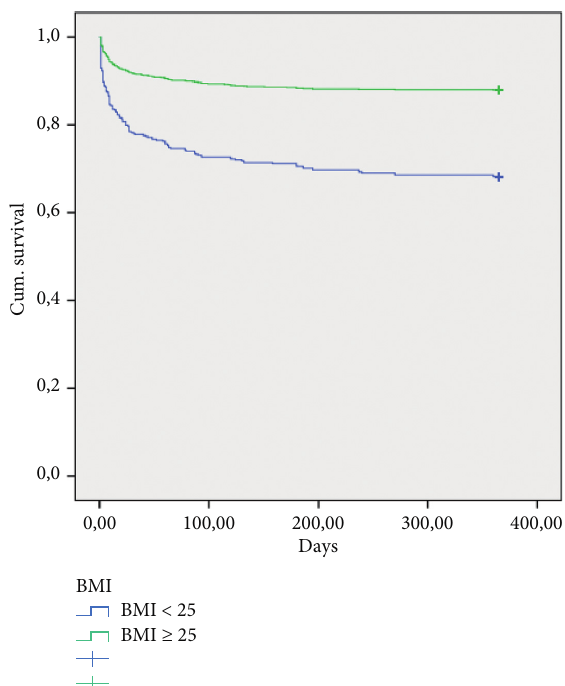
Figure 1: Kaplan–Meier curve showing the survival curve of patients with BMI < 25 compared with patients with BMI ≥ 25.